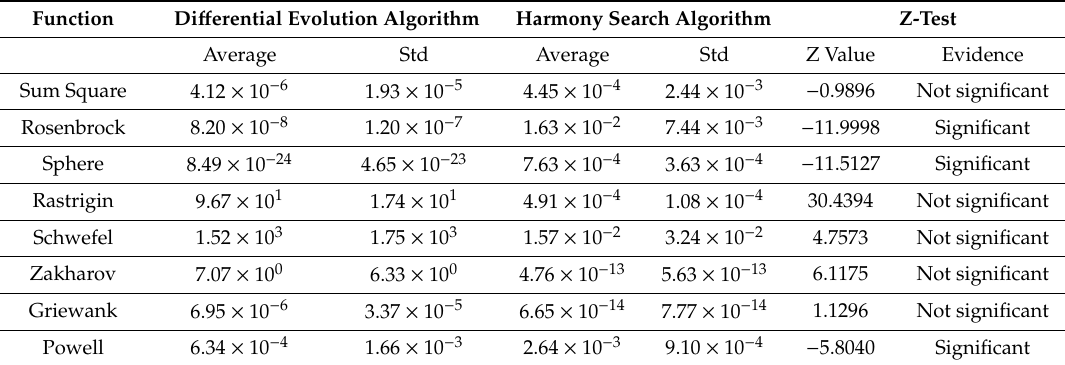
Table 14. Results for the statistical test.